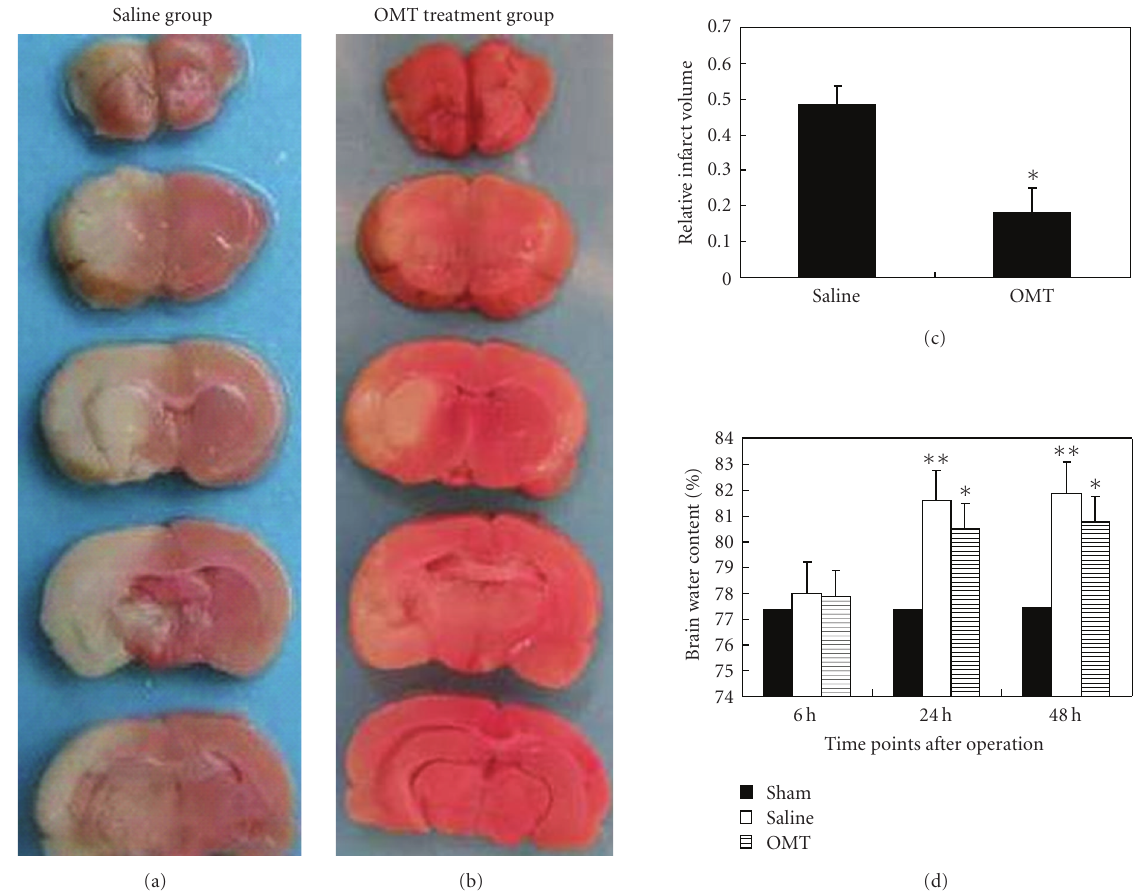
Figure 2: Relative infarct volume and water content in the brain. (a) and (b) TTC stain: comparison of infarct size between the saline group and OMT treatment group at 24 hours. The white region was the infarction and the red region was normal brain tissue. (c) Relative infarct volume: calculating and comparing the percentage of infarct region occupying the whole brain tissue area in one section revealed that it decreased by 32% in the OMT treatment group compared with the saline group at 24 hours. ∗ P < . 05 compared with saline group. (d) Water content of cerebral tissue: there was no di ff erence at 6 hours among the test groups. It increased at 24 hours in the saline group and lasted up to 48 hours in the saline group at identical time points. Water content in the OMT treatment group decreased at 24 hours and 48 hours after the operation compared with that in the saline group at the same time points. Results are means ± SD of each group. ∗∗ P < . 01 and ∗ P < . 05 compared with